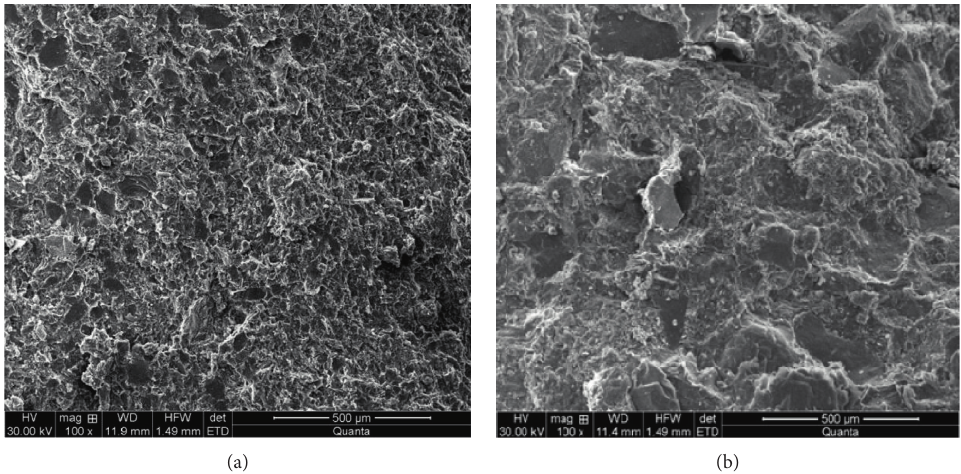
Figure 1: SEM images of sandstone with a magnification of 100